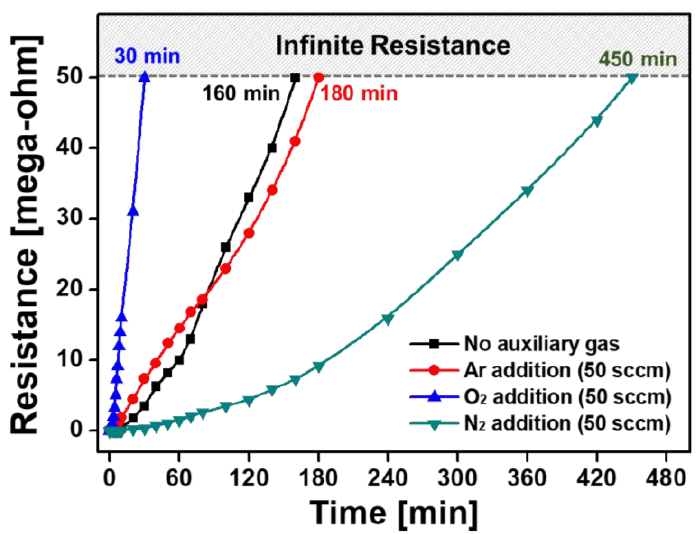
Figure 8. Changes in the electrical resistance of ex situ I 2 -doped PANI films on IDE substrates synthesized with and without auxiliary gases (Ar, O 2 , and N 2 ).